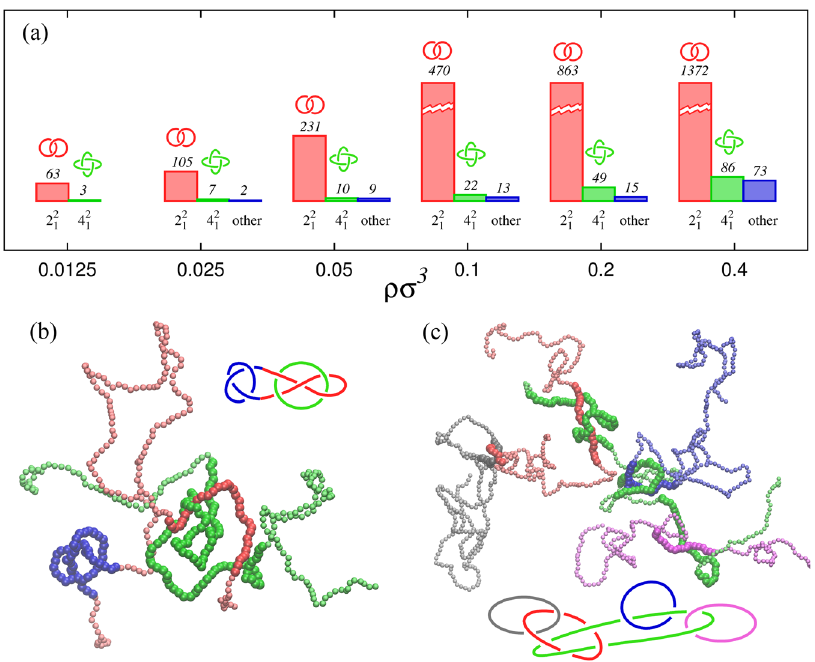
Figure 6. Topological complexity in melts: ( a ) Topological spectrum associated to the physical links found in the melt at different solution density ρσ 3 . As ρ increases, the category “other”, where all the more complex links are collected, gets more and more populated. Two configurations of this category, found at ρσ 3 = 0.1, are represented in panels (b,c). Panel (b) refers to a physical Whitehead link that additionally host a physical knoy (trefoil). Panel (c) represents a 5 component physical link where the chains are catenated in pairs with either Hopf or Solomon